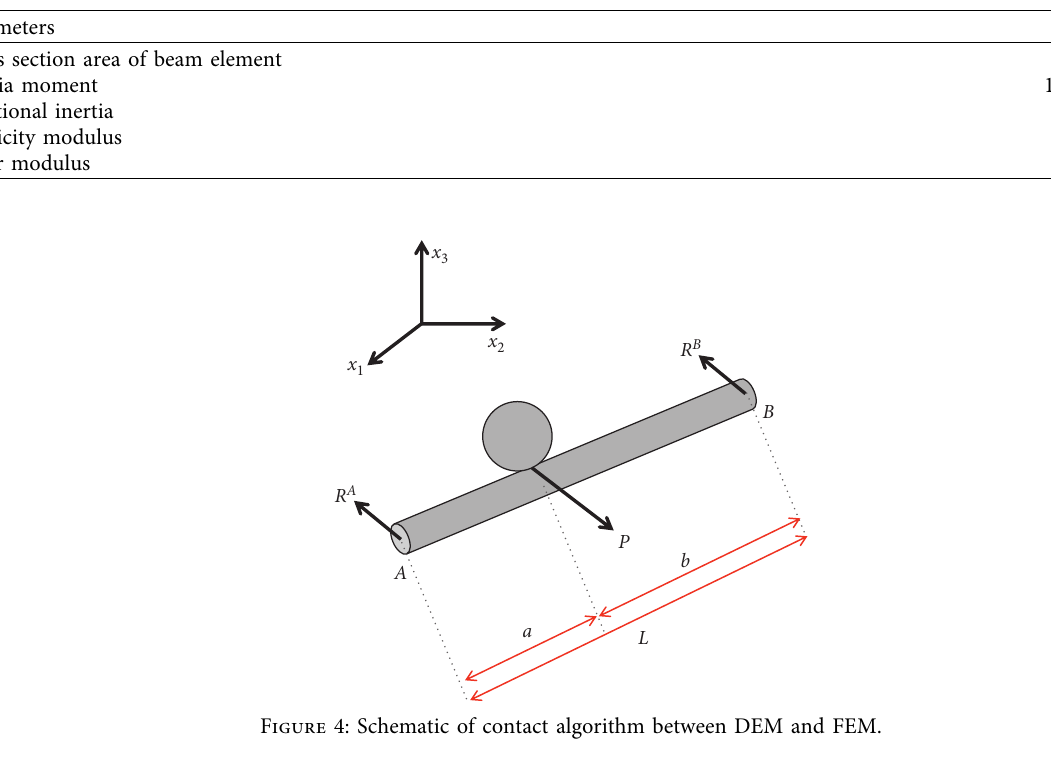
Figure 3: The geogrid type and its FEM model. (a) Geogrid type. (b) FEM model of geogrid. Table 1: Computational parameters of FEM.